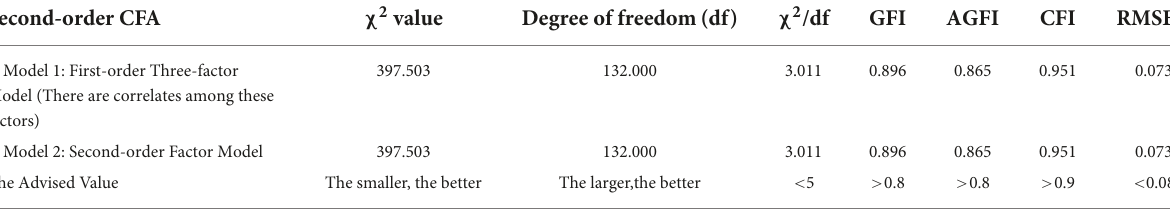
TABLE 5 Second-order model confirmatory factor analysis